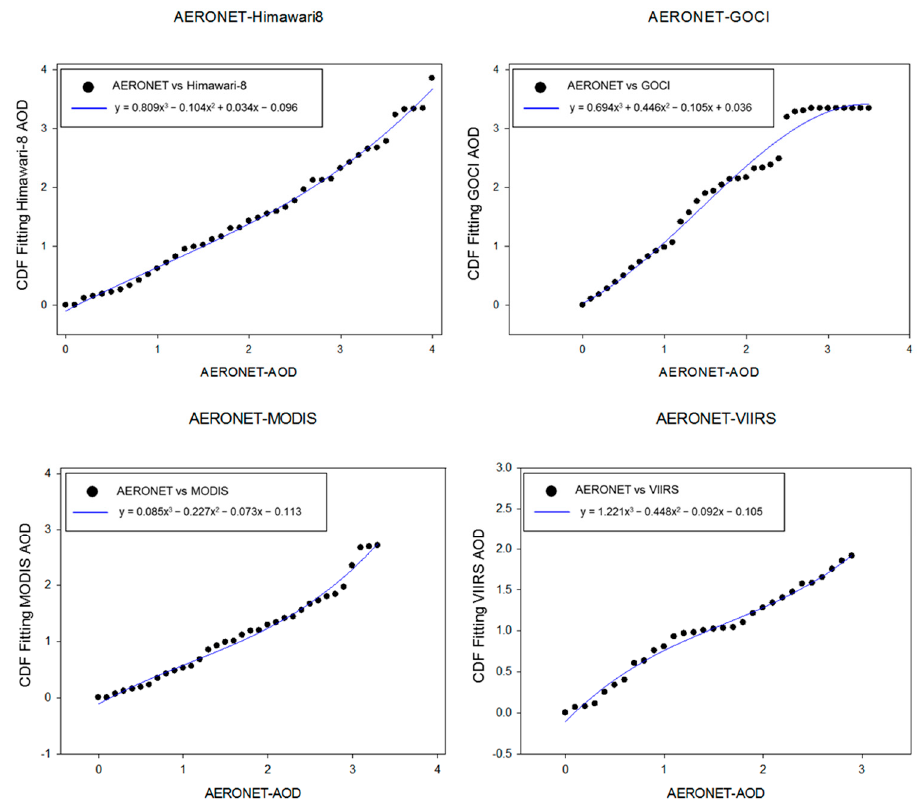
Figure 4. Plots of satellites AOD against Anmyondo AERONET site data during 2016 (training data): ( a ) Himawari-8/AHI, ( b ) COMS/GOCI, ( c ) Aqua Terra/MODIS, and ( d ) Suomi-NPP/VIIRS.